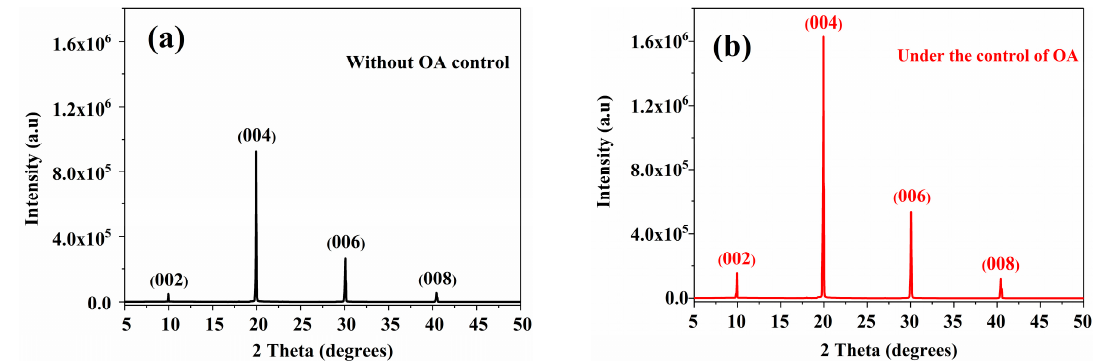
Figure 4. X-ray diffraction patterns observed for the DAST single crystals grown ( a ) without the OA control; ( b ) under the control of the OA.